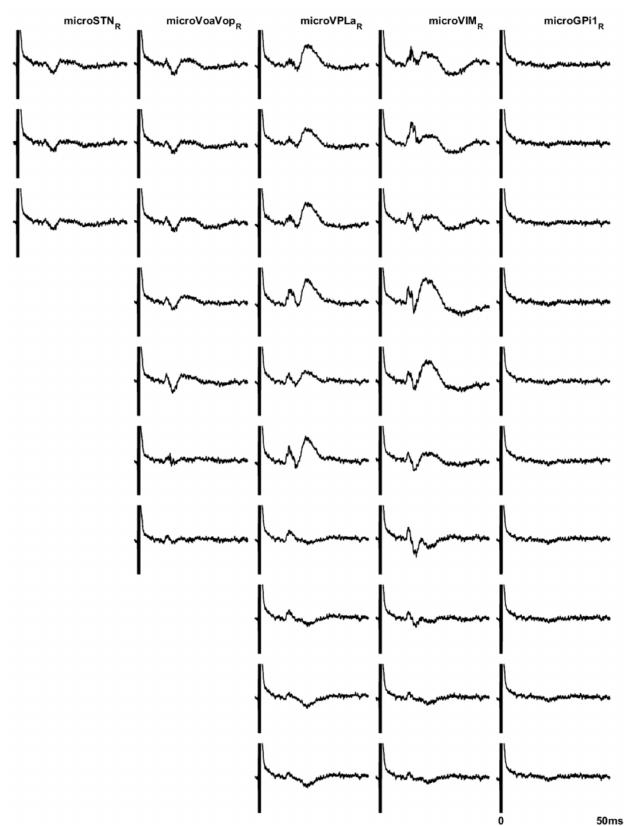
Figure 1. Example of evoked potentials recorded on the high-impedance contacts in (from left to right) subthalamic nucleus (STN), VoaVop, VPL, Vim, and globus pallidus (GPi). Top to bottom traces show averaged data from proximal to distal contacts. Vim and VPL have a robust response at approximately 14 ms after the stimulus, whereas a much smaller response is seen in Vo and STN.